Question: Write a single sentence explaining what this figure depicts.
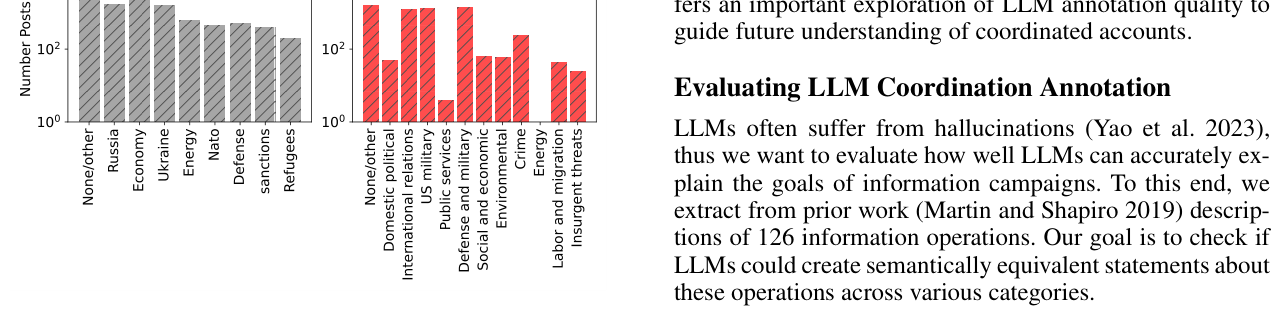
Answer: The frequency of concern posts in human anno- tated validation data. (a) 2022 French election and (b) 2023 Balikatan U.S.-Philippines military exercises.